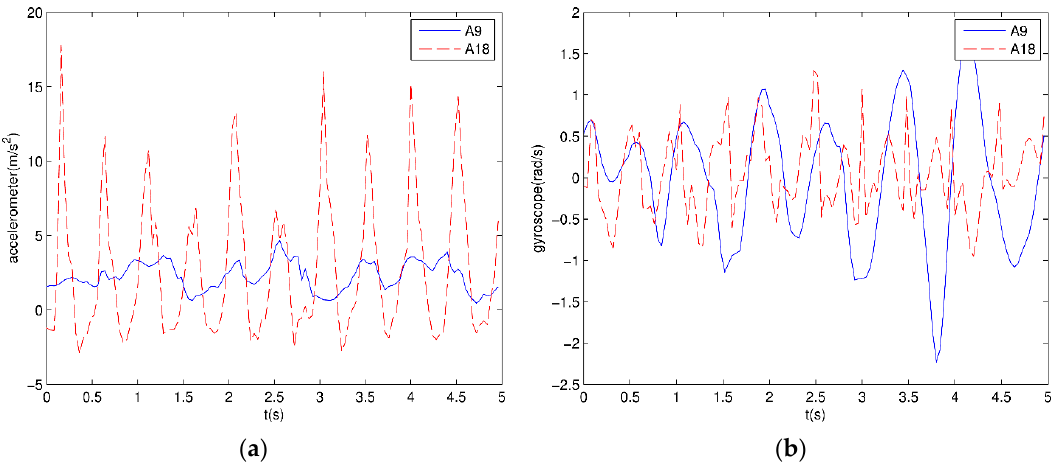
Figure 4. Sensor signals: ( a ) z -axis acceleration signals of the right arm for jumping and walking; ( b ) z -axis gyroscope signals of the right arm for jumping and walking.